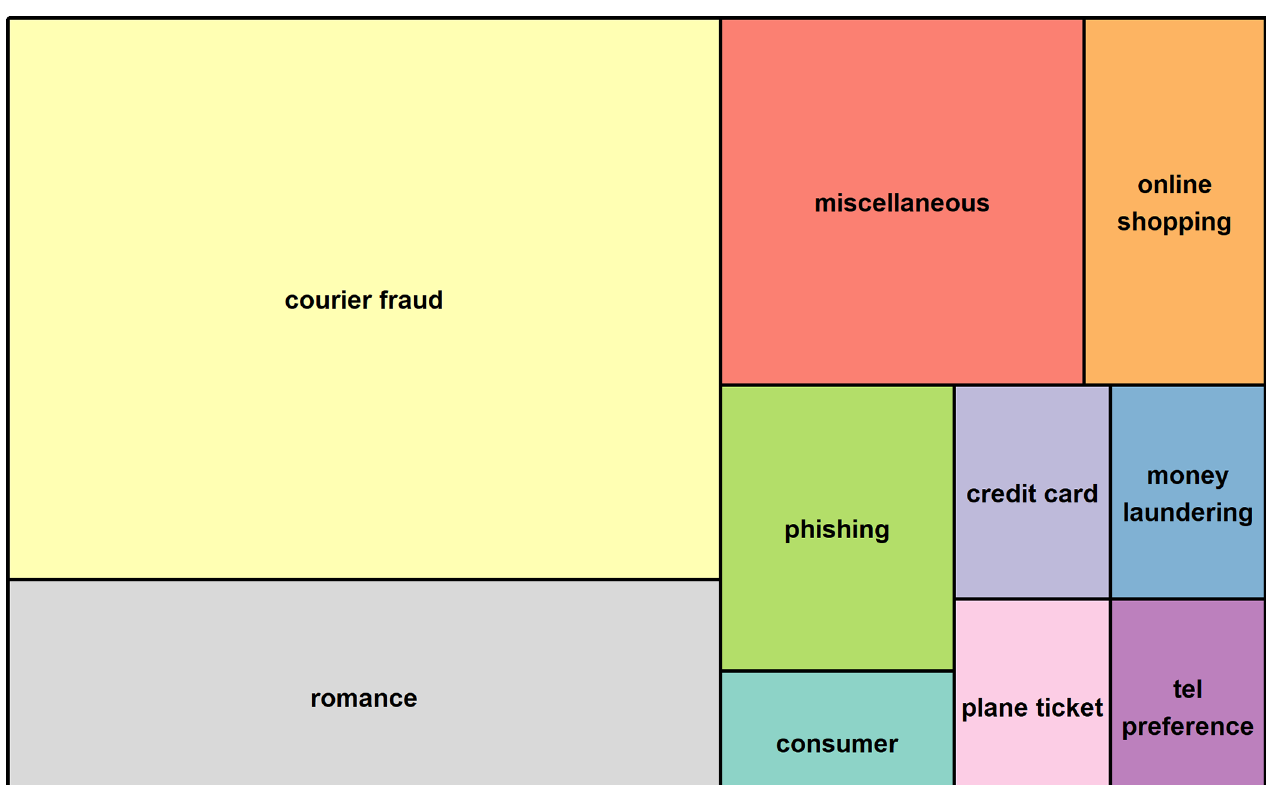
Figure 4: Tree diagram of ‘NFIB90’